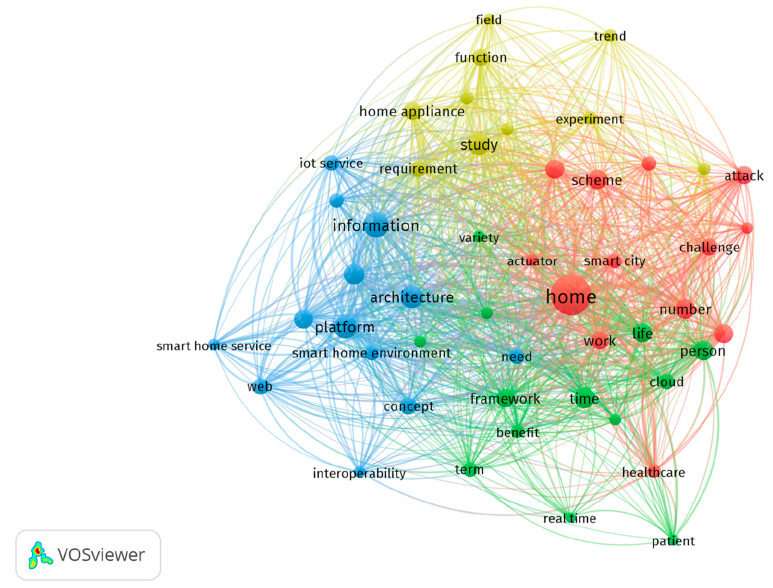
Figure 8. Analysis of co-occurrences in the top 60 keywords.